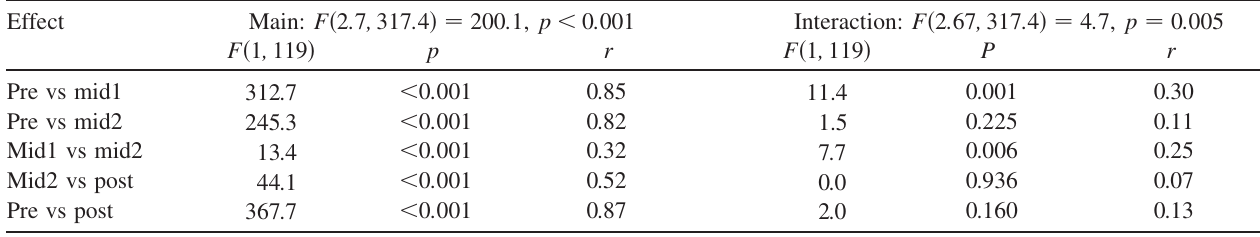
TABLE II. Repeated measure analysis of variance: total